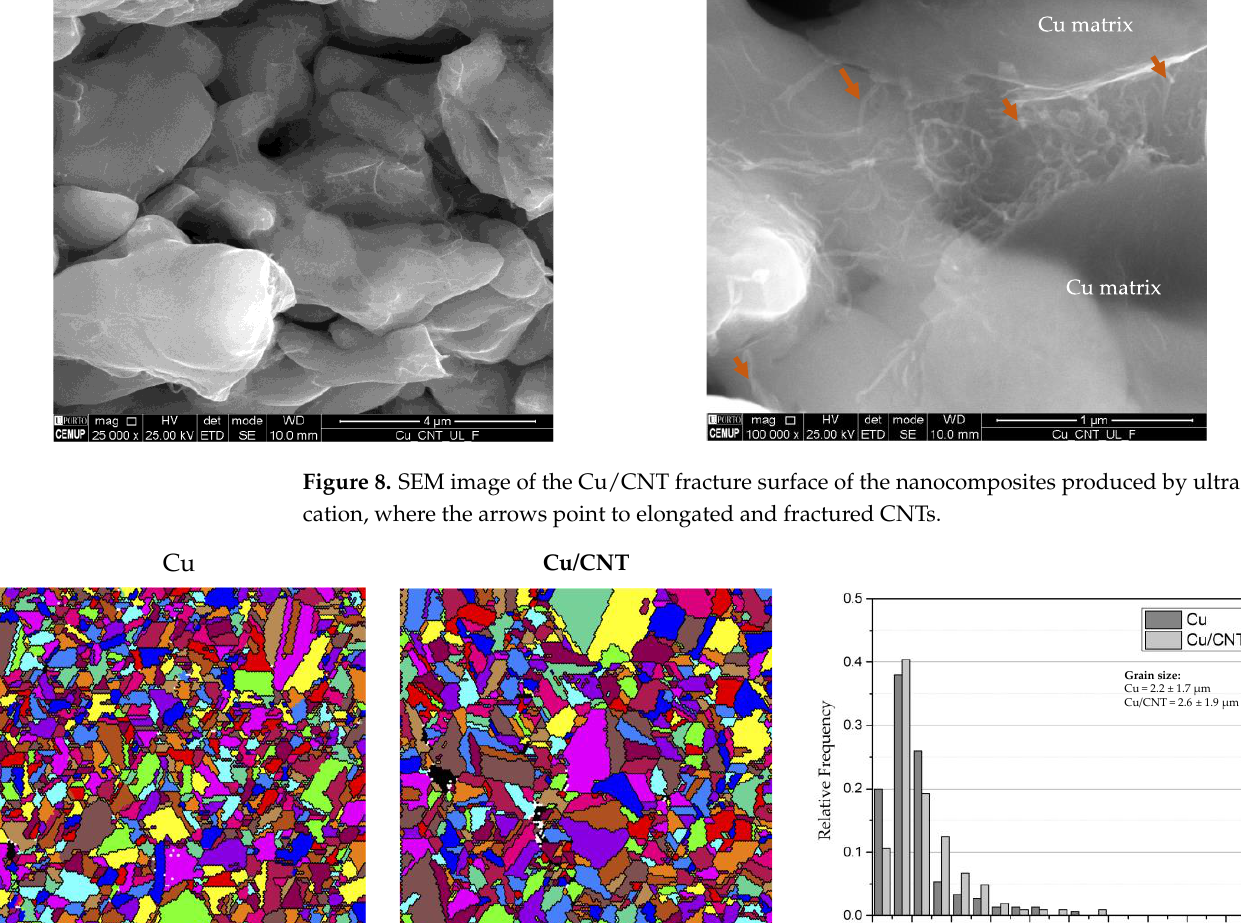
Figure 8. SEM image of the Cu/CNT fracture surface of the nanocomposites produced by ultrason- ication, where the arrows point to elongated and fractured CNTs.